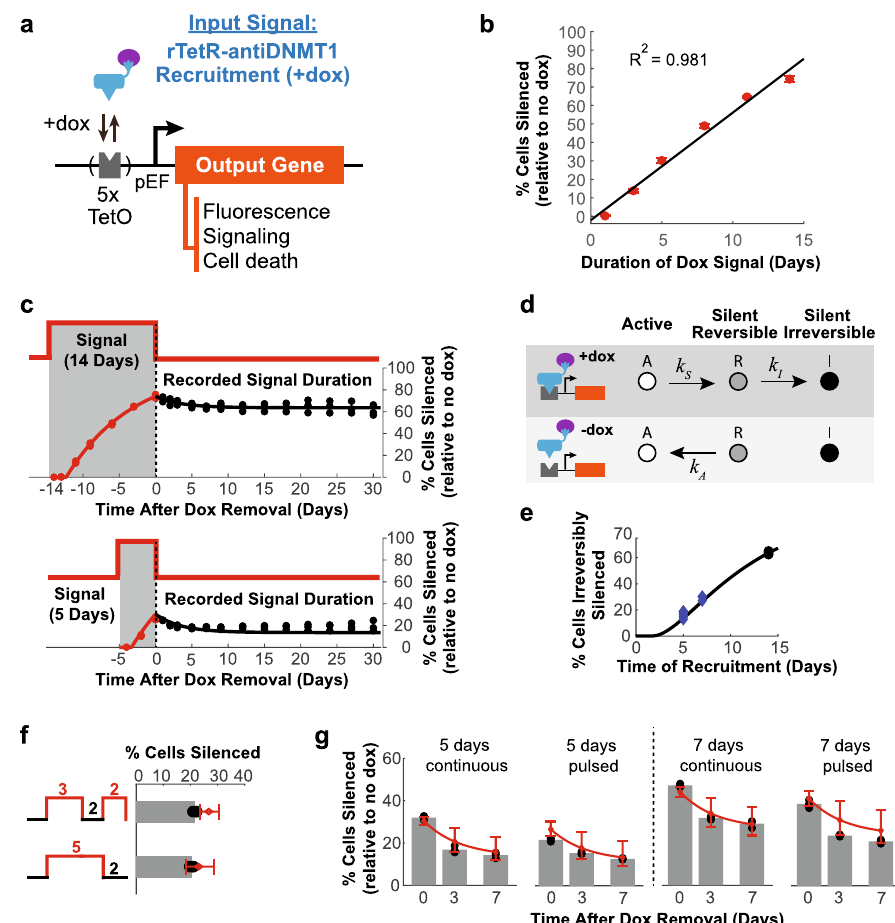
Fig. 4 Nanobodies as signal detection and recording tools. a Schematic of a device for measuring and recording signal duration. The input signal is coupled to the recruitment of rTetR-antiDNMT1 near the pEF promoter to silence an output gene. b Percentages of cells with TagRFP reporter silenced as measured by fl ow cytometry at the end of the indicated dox signal durations in a cell line stably expressing rTetR-antiDNMT1. Means and SDs of experimental data from three replicates (red dots) and linear fi t (black, “ Methods ” ). c Percentage of cells with TagRFP silenced after different signal (dox treatment) durations: 14 days (top) and 5 days (bottom). The gray shaded regions (negative numbers) indicate the period with dox. Dashed lines indicate dox removal. Continuous lines represent fi ts to the model in d for the 14 days data and predictions of the model for the 5-day data ( “ Methods ” and Supplementary Note). d Three-state model of silencing by antiDNMT1 during recruitment ( + dox, top) and during release ( − dox, bottom). e Percentage of cells irreversibly silent after different durations of recruitment (dox treatment) predicted by the model in d are plotted as a black line ( “ Methods ” ). Experimental data recorded at 7 days during the release period shown as black dots if used for model fi tting (14 days), or blue diamonds if not used in the fi t. f Percentages of cells silenced relative to no dox controls for pulsed recruitment (top: 3 days + dox, 2 days − dox, 2 days + dox) compared to continuous recruitment for the same duration (bottom: 5 days + dox, 2 days − dox). Experimental data from three replicates shown as black dots, means as gray bars, and model predictions with 95% CI in red ( “ Methods ” ). g Percentages of cells silenced relative to no dox controls for pulsed recruitment vs. continuous recruitment, recorded at the same time after dox removal, plotted as in f . Source data are available in the Source Data fi